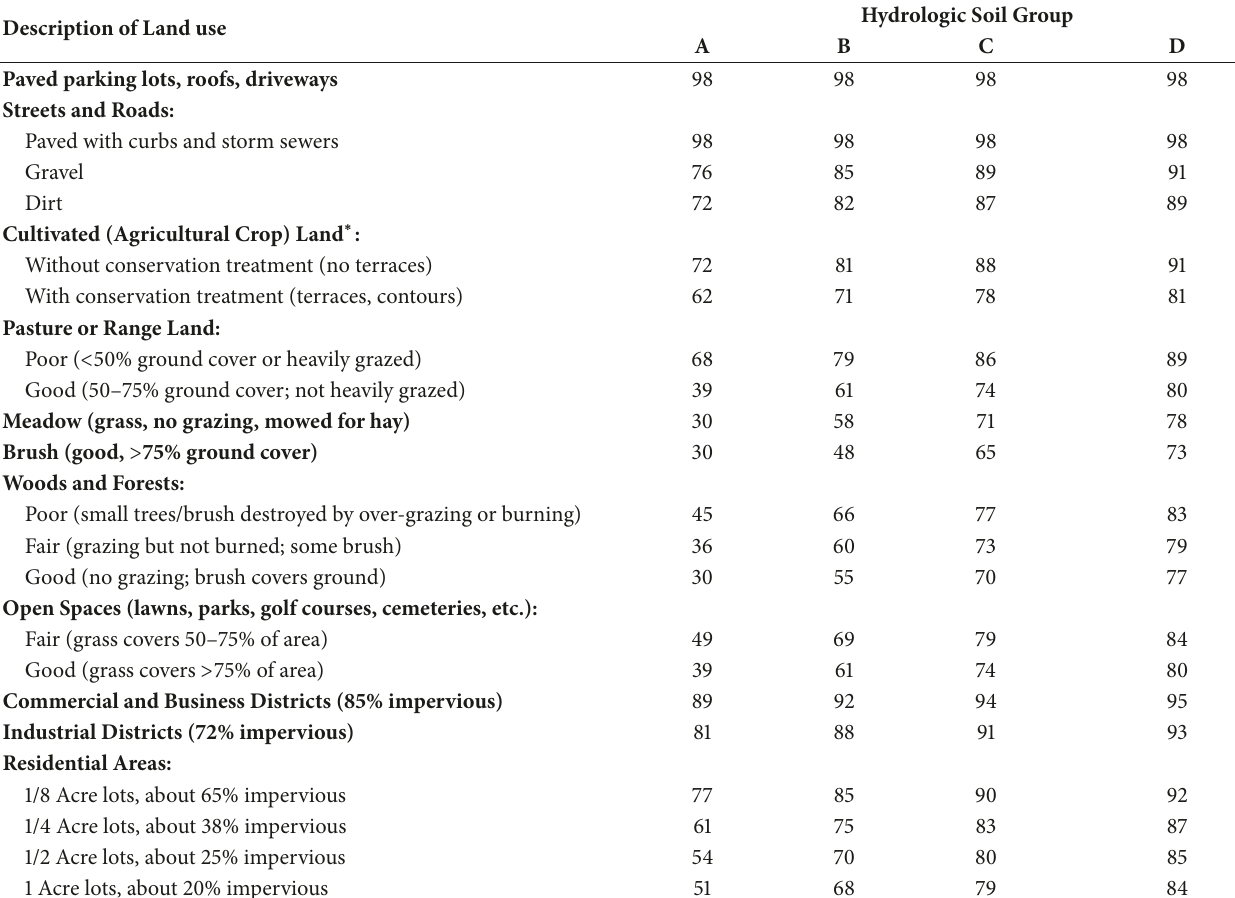
Table 1: Runoff curve